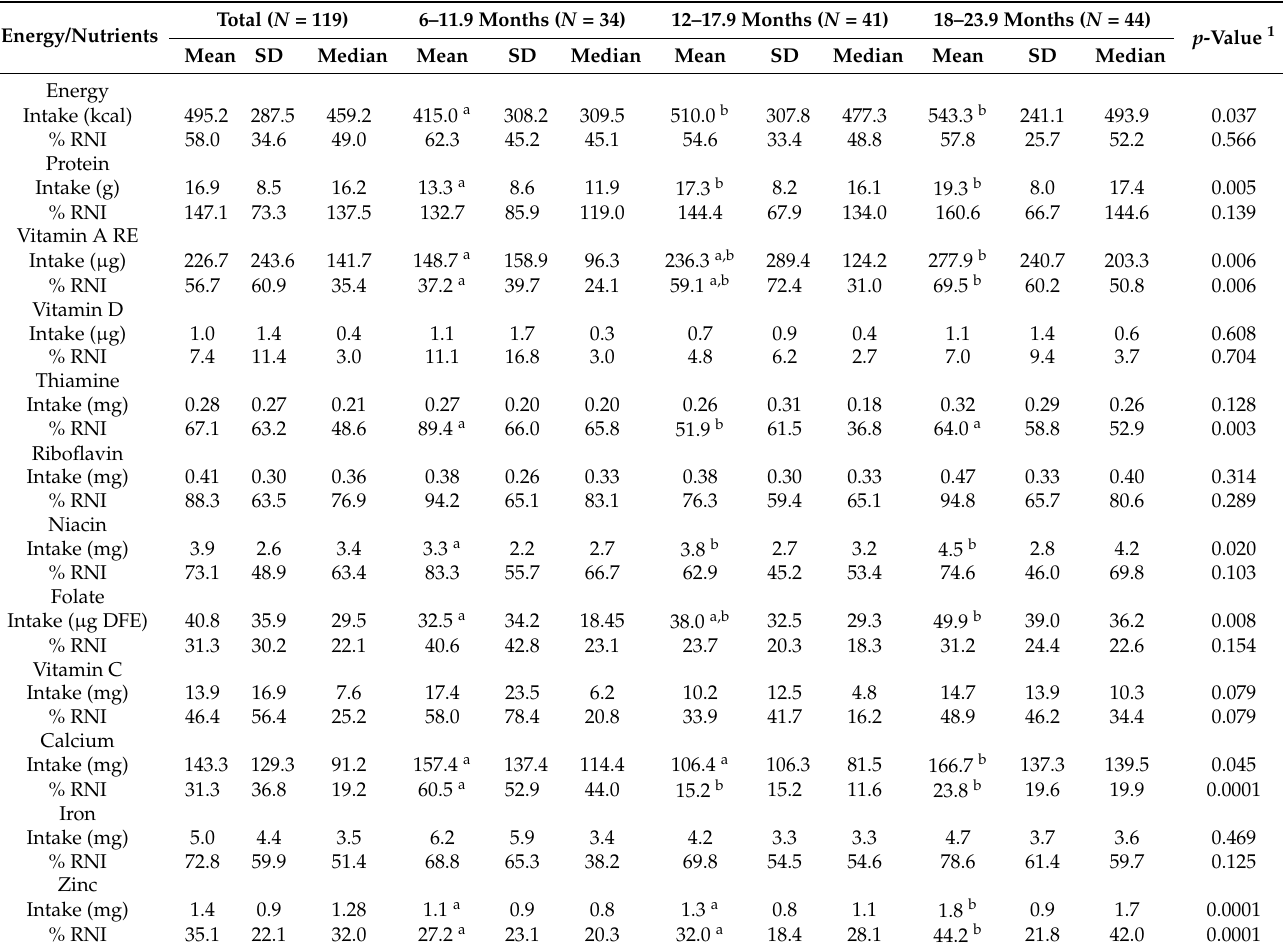
Table 3. Energy and nutrient intake from complementary foods per day (mean ± SD and median) according to age group.